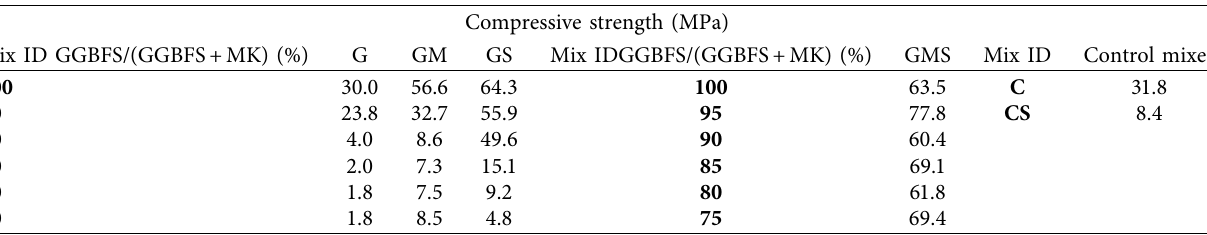
Table 3: The average compressive strengths in MPa after seven days.